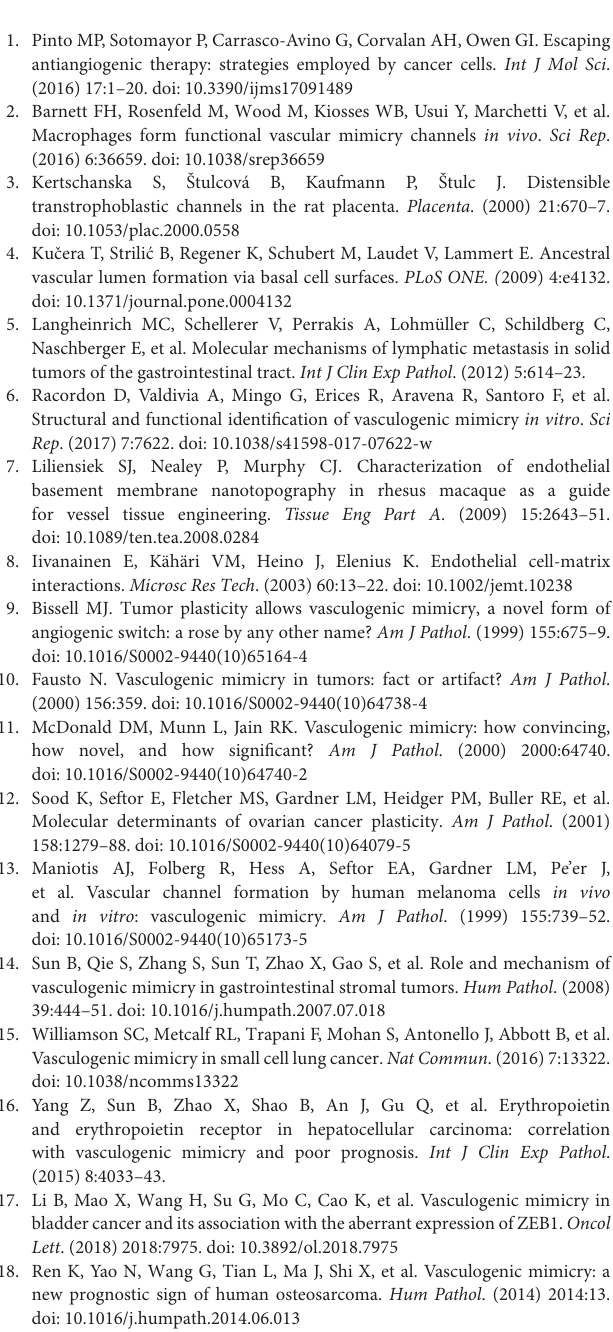
C = VM Pattern (PAS Stain). In vitro characterization: 5 = only light microscopy; 6 = light microscopy/PAS; 7 = electron/confocal microscopy; 8 = lumen presence demonstration; 9 = functionality demonstration (microinjection); W = Others; X = cells projection; Y = tubular structures; Z = Not Shown. Xenograft model: Y = Yes; N = No. Supplementary Video 1 | Dye Microinjection of Different Structures Formed by the U87 and Hey Cell